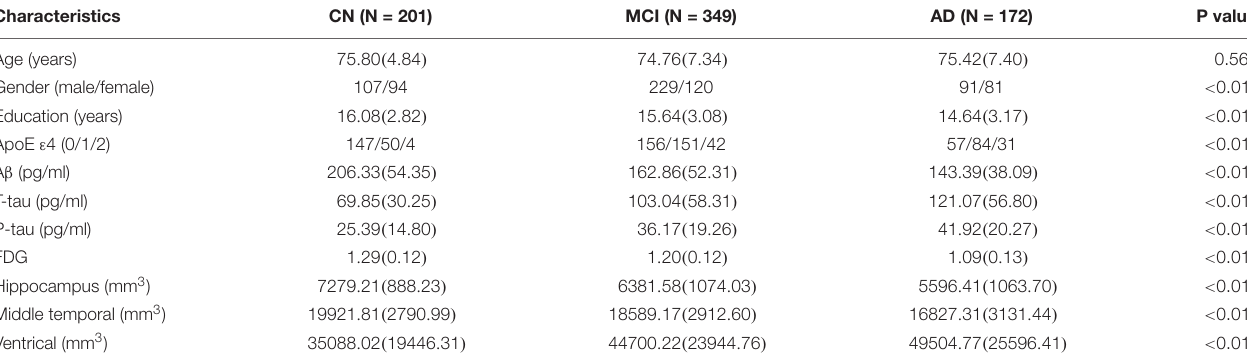
TABLE 1 | The characteristics of the subjects in clinical group at baseline.